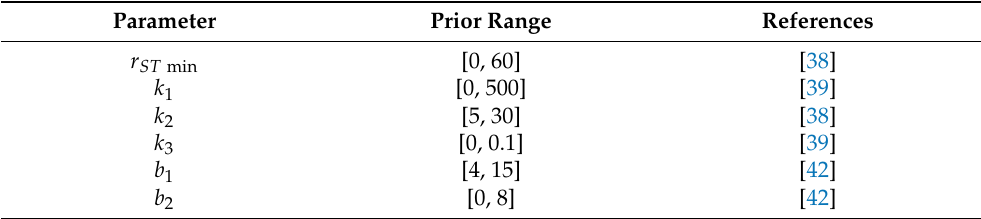
Table 2. Prior distributions used for estimating the posterior distributions of the model parameters associated with canopy and soil surface